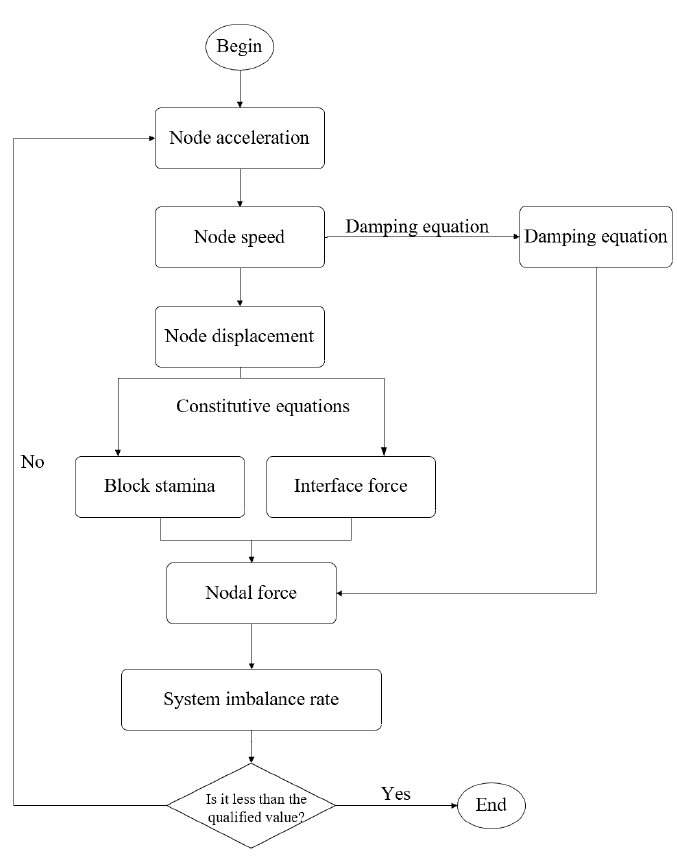
Figure 22. Flow chart of CDEM calculation steps.